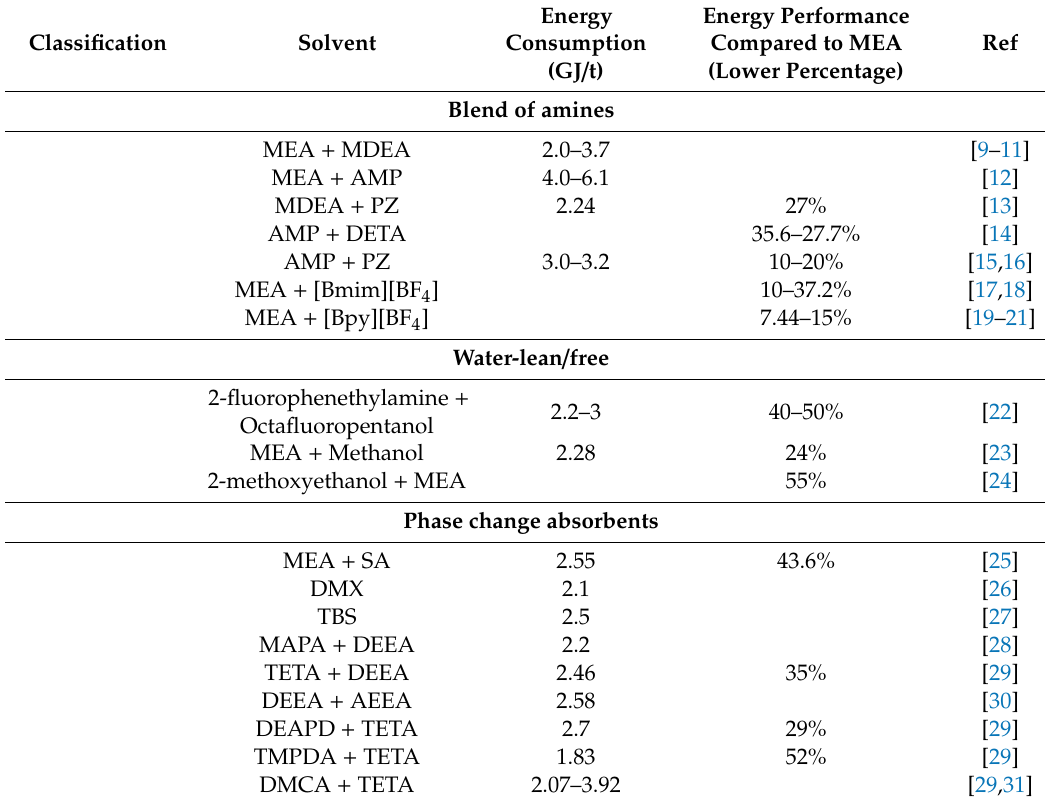
Table 1. Energy consumption performance of di ff erent chemical